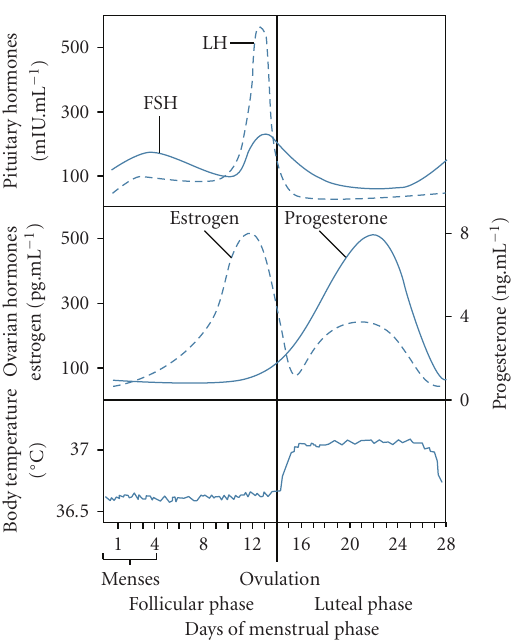
Figure 4: The variation of gonadotropic and sex steroid hormones, and the subsequent changes in daily body temperature across the full menstrual cycle. During the pre-ovulatory FP, estrogen levels are high. During the post-ovulatory LP, increasing levels of circulating progesterone are observed, along with increased daily body temperature. FSH, follicle stimulating hormone; LH, luteinizing hormone; FP, follicular phase; LP, luteal phase. From [22], as adapted from